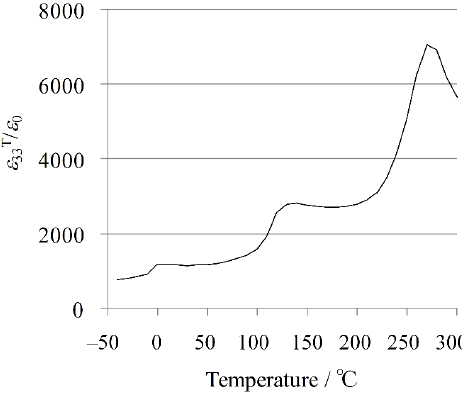
Figure 2. Temperature dependence of dielectric permittivity for KNN ‐ CZ ‐ 2 single ‐ layer sample. Next, a multilayer KNN ‐ CZ ‐ 2 sample was fabricated. A multilayer piezoelectric structure with